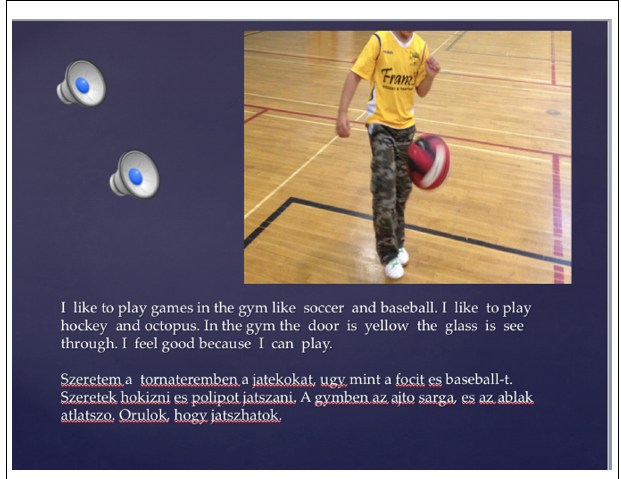
FIGURE 2 | Pali’s PowerPoint slide.